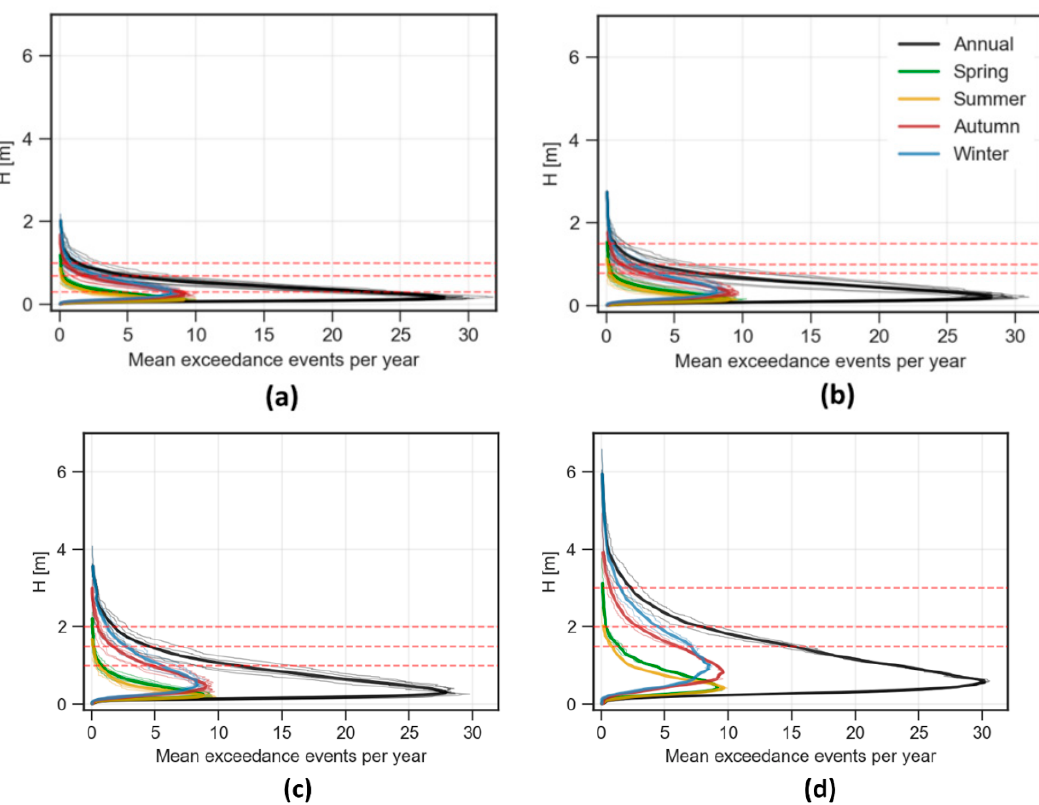
Figure 5. Complete and seasonal curves of mean number of exceedance events per year for each unique value of wave agitation propagated from the control scenario of the GCM MIROC5. Bold lines represent mean trends for each AOI typology, whereas pale lines represent the individual trends of the AOIs belonging to each typology (notice that mean trends are indeed representative of these individual trends). Red dashed lines represent the thresholds assigned to each typology as stated in Table 3: ( a ) Type1; ( b ) Type2; ( c ) Type3; ( d ) Type 4.